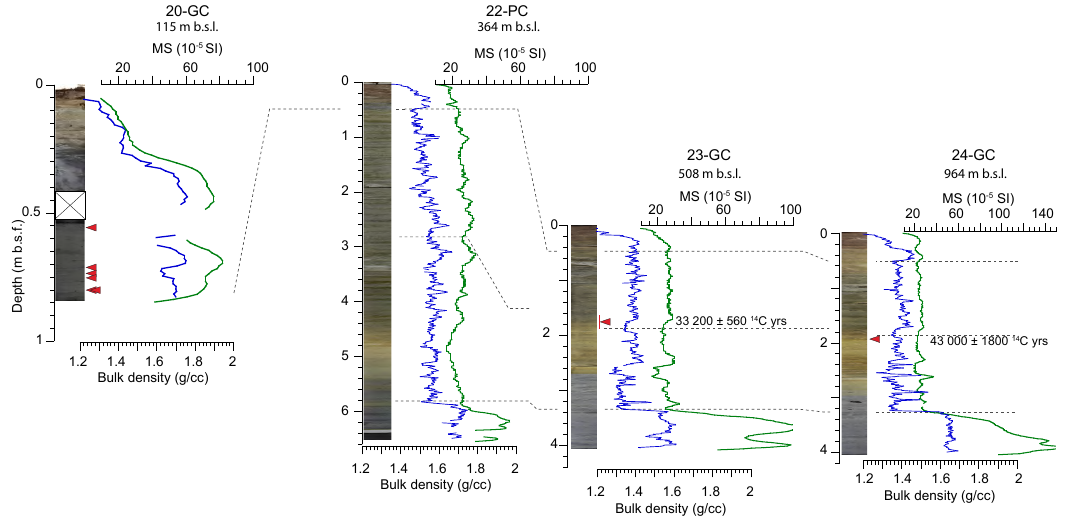
Figure 3. Transect of the East Siberian Sea cores SWERUS-L2-20-GC, 22-PC, 23-GC, and 24-GC crossing the shallow shelf (20-GC) and the slope of the East Siberian Sea (22-PC, 23-GC, 24-GC) showing core photos, radiocarbon date locations, magnetic susceptibility, and bulk density. Radiocarbon dates indicate that the deglacial, dense, high-susceptibility, dark gray sediments recovered in the lower half of 20-GC are not correlative to a similar lithology at the base of 22-PC, 23-GC, and 24-GC, which predate the LGM. They are potentially correlative to a thin, higher-susceptibility, and dense gray sediment layer found in the upper 50cm of the slope cores.